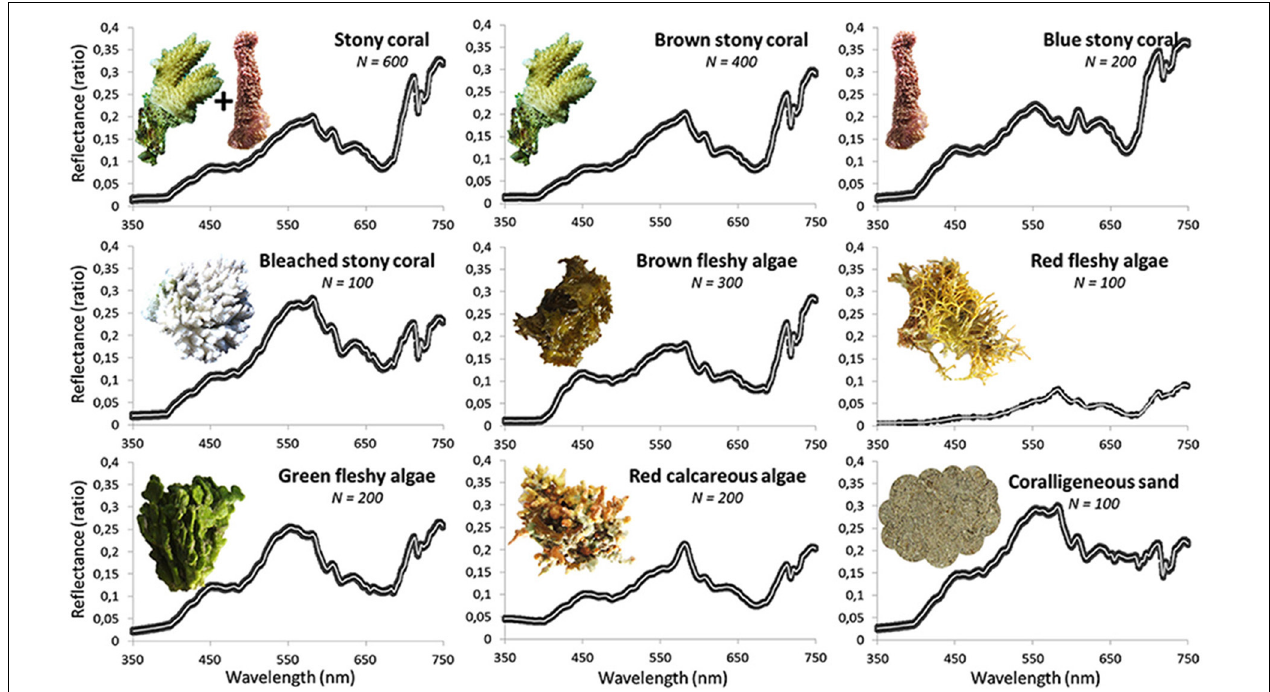
FIGURE 2 | Line plots of mean and standard error reflectances of the eight coral reef habitats across wavelengths (350–750nm with 1nm accuracy). The left hand corner line plot, entitled stony coral,